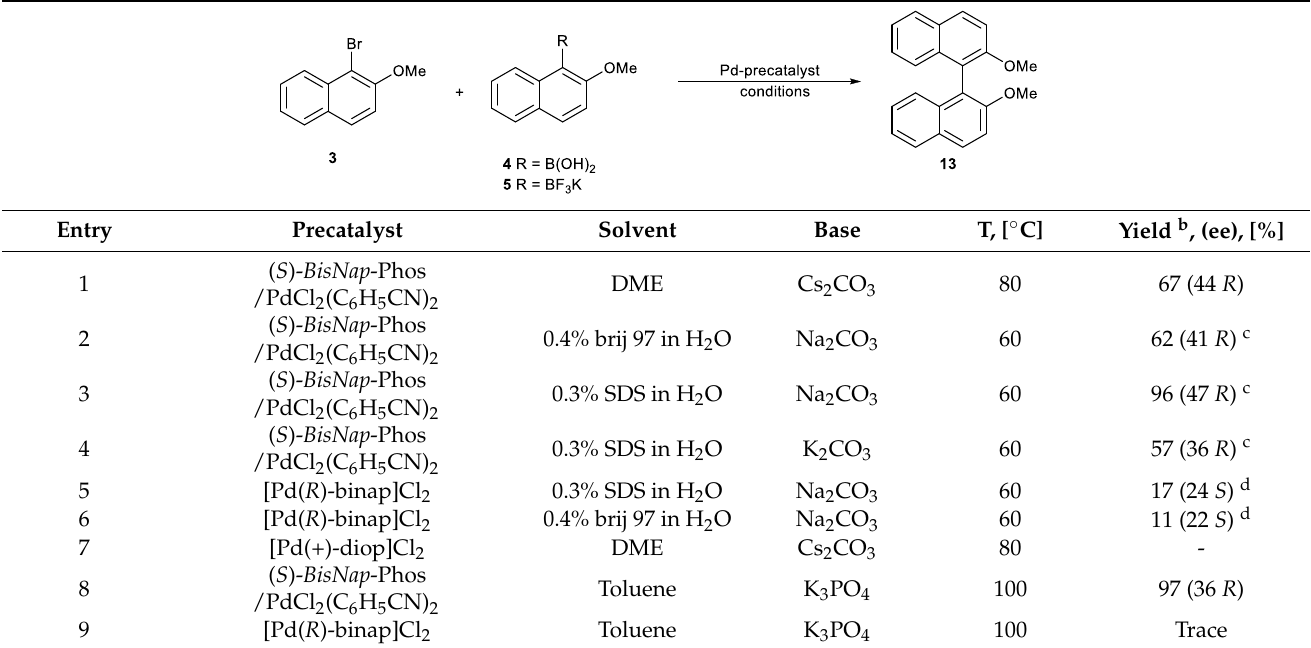
Table 10. Ligand activity in asymmetric synthesis of 13 a .